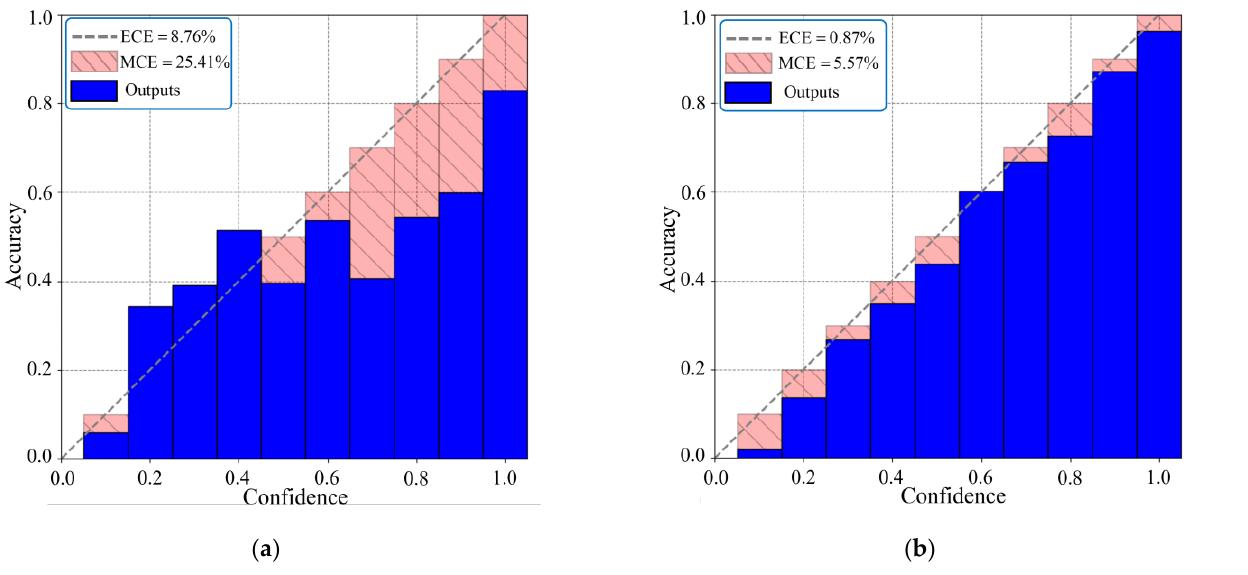
Figure 4. The reliability diagrams of the classification model before and after calibration. ( a ) Relia- bility diagram of the original model; ( b ) Reliability diagram of the calibrated model. diagram of the original model; ( b ) Reliability diagram of the calibrated